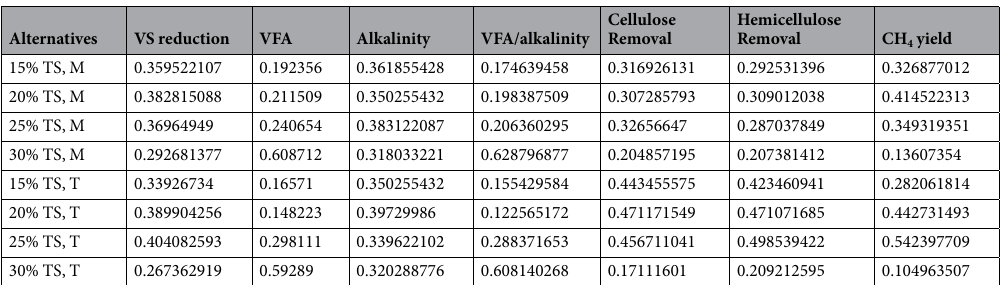
Table 7. The normalized decision matrix for TOPSIS method.